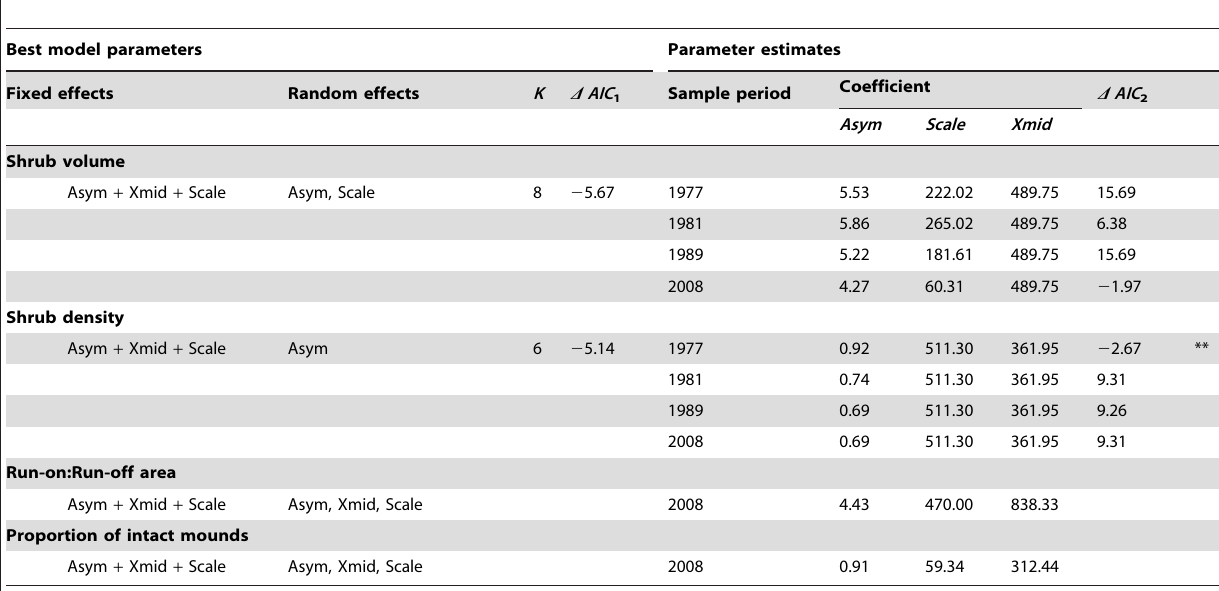
Table 1. Best-fit mixed-effects logistic growth model selection results and parameter estimates for canopy shrub volume, shrub density and ecological functioning.